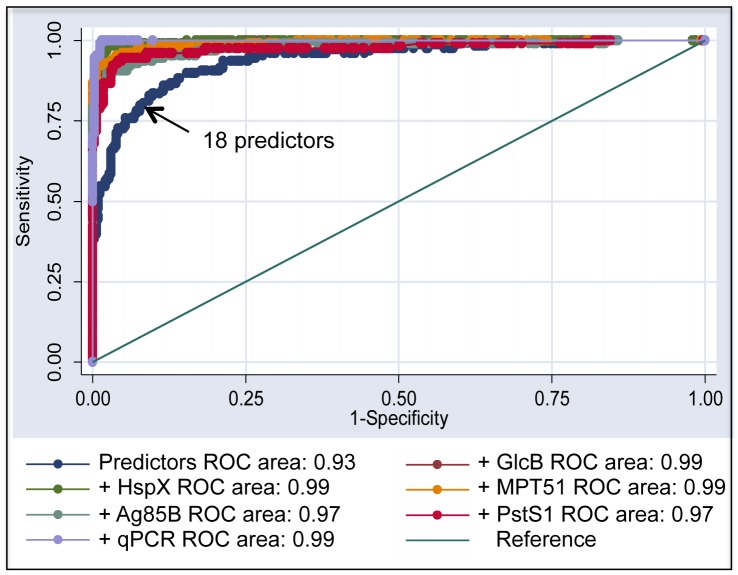
ROC curves for logistic regression analysis of ‘Probable and Possible’ TBM samples.Predictor model (18 predictors) applied to ‘Probable and Possible’ TBM combined with ELISA/qPCR.